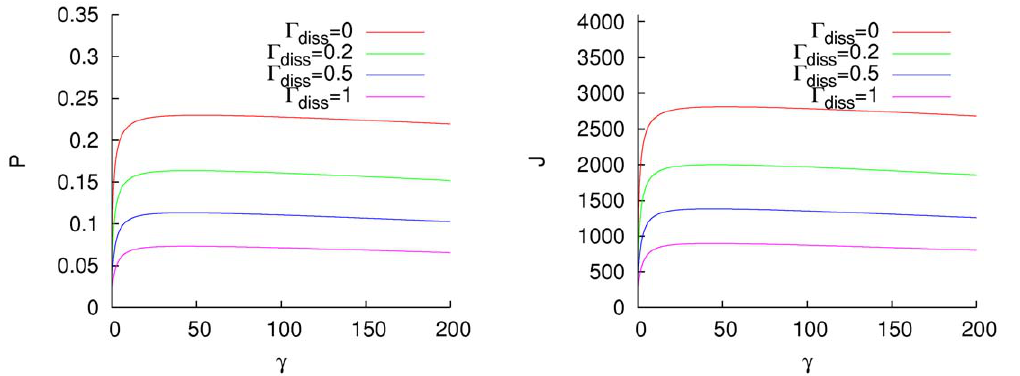
Figure 5. Excitation (left) and energy (right) fluxes from the network to the sink for the FMO Hamiltonian as functions of the dephasing ratio, n ~ 1 . Units of cm { 1 .